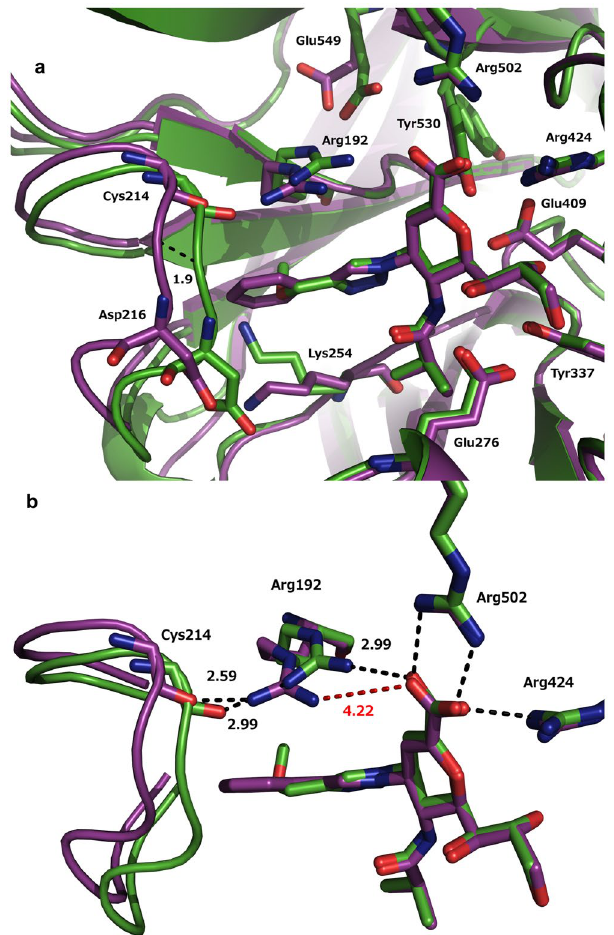
Figure 2. Structural insights into hPIV-3 HN– 5 and – 6 complexes. ( a ) Superimposition of the hPIV-3 HN active site with bound inhibitor 5 and bound inhibitor 6 (magenta and green, respectively). A further 1.9 Å shift in 216-loop position led to the accommodation of the bulkier 4-phenyltriazole in the hPIV-3 HN– 5 complex (dashed-line in black). ( b ) Zoom-in image displays the distances between active site residues Arg192 (side-chain) and Cys214 (backbone carbonyl oxygen) as well as the Arg192 side-chain and inhibitors 5 and 6 . Dashed-lines in black or red represent favourable (H-bond donor–acceptor distance < 4.0 Å) and unfavourable distance (H-bond donor–acceptor distance > 4.0 Å) for hydrogen bonds and salt bridge formation respectively. O red, N